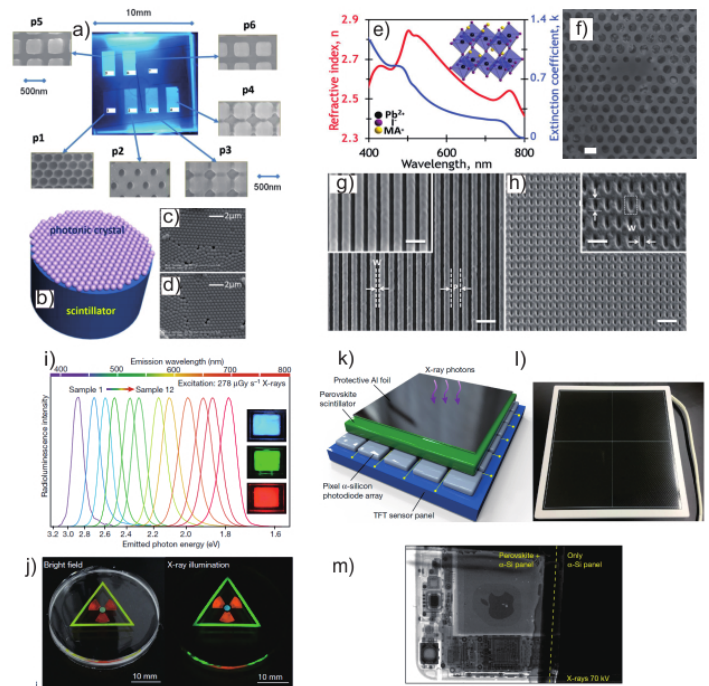
Figure 7. Nanotechnology improvements of scintillators. ( a ) Photonic crystals for the extraction efficiency improvements produced with e-beam lithography in Si 3 N 4 on a scintillator. ( b ) Schematic illustration of the self-assembled photonic crystal structures covered on the surface of scintillator. ( c , d ) Scanning electron microscope image of self-assembled photonic crystals from polystyrene spheres. ( e ) Refractive index and extinction coefficient of MAPbI 3 obtained from ellipsometry while the